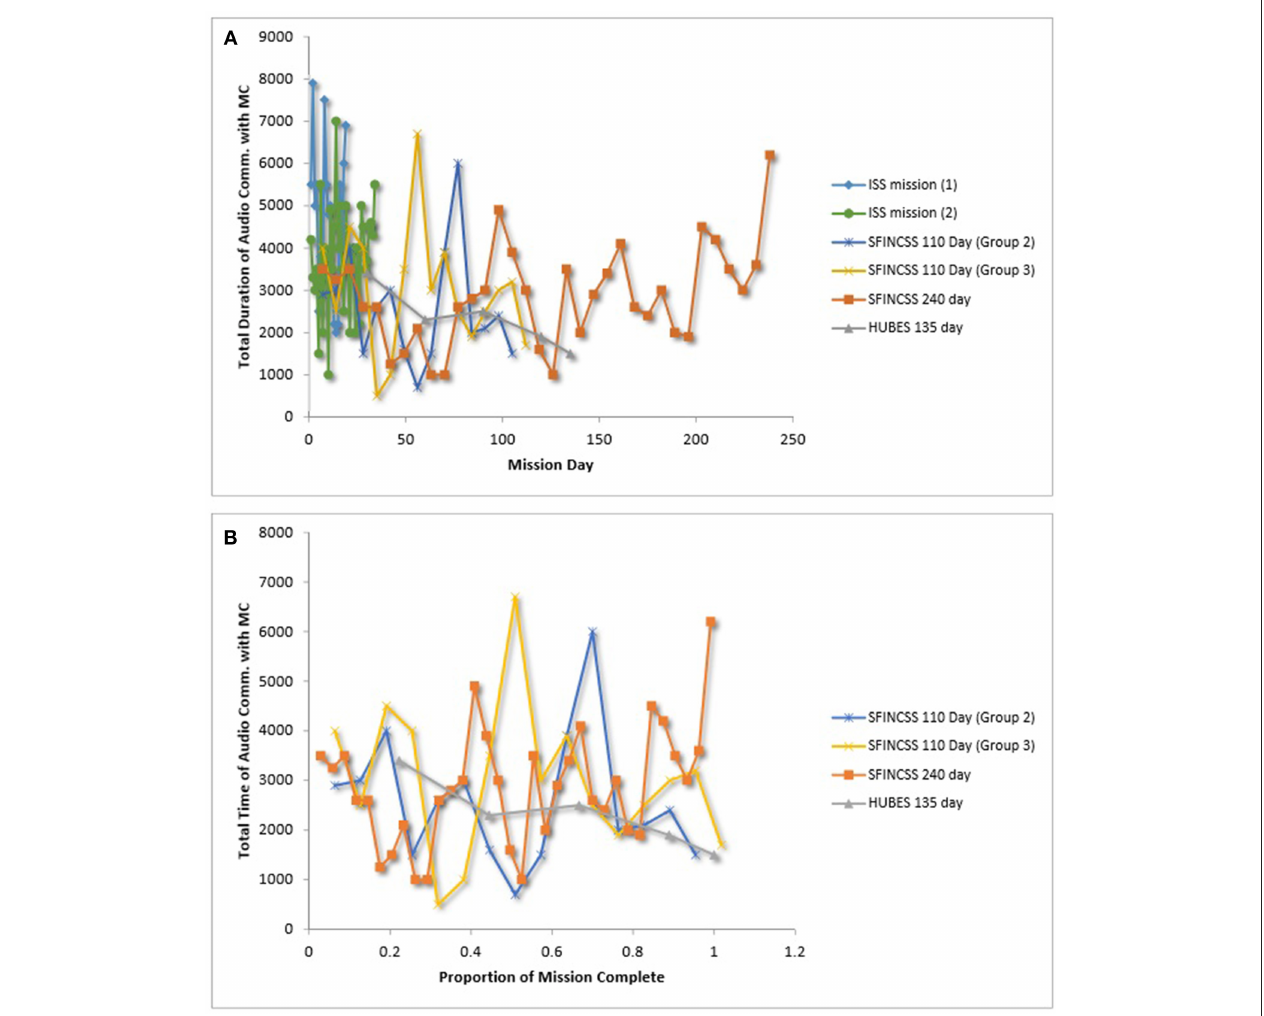
FIGURE 6 | (A) Team communication with mission control over time. (B) Team communication with mission control over relative time. Gushin et al. (1997), Gushin et al. (2001) , Gushin and Yusupova (2003).